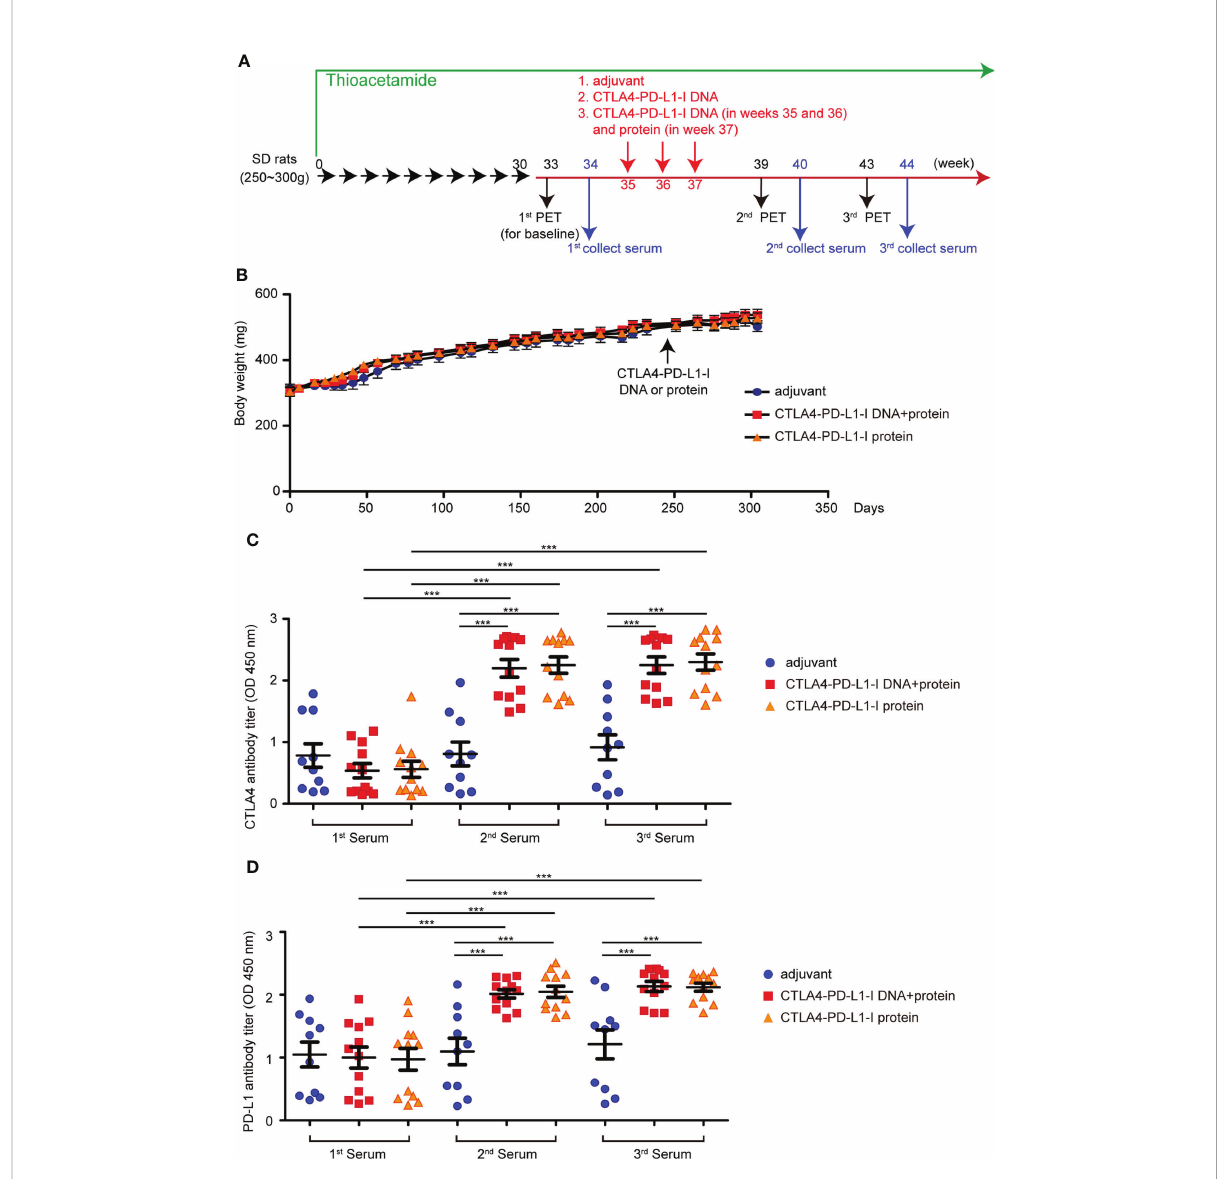
FIGURE 1 The effect of CTLA4-PD-L1-I DNA or protein vaccine. (A) A schema for experimental design for Figure 1. (B) The average body weight of rats (N ≥ 10) receiving TAA in each experiment arm for 320 days. (C) The CTLA4 antibody titers expressed as the OD450 nm were determined after six weeks (2 nd ) and ten weeks (3 rd ) of CTLA4-PD-L1-I DNA, CTLA4-PD-L1-I protein, or control adjuvant (Freund ’ s adjuvant). N ≧ 10. The values are from two independent experiments and presented as the mean ± SEM. ***P< 0.001 by Student ’ s t -tests. (D) The PD-L1 antibody titers expressed as the OD450 nm were determined after six weeks (2 nd ) and ten weeks (3 rd ) of CTLA4-PD-L1-I DNA, CTLA4-PD-L1-I protein, or control adjuvant (Freund ’ s adjuvant). N ≧ 10. The values are from two independent experiments and presented as the mean ± SEM. ***P< 0.001 by Student ’ s t